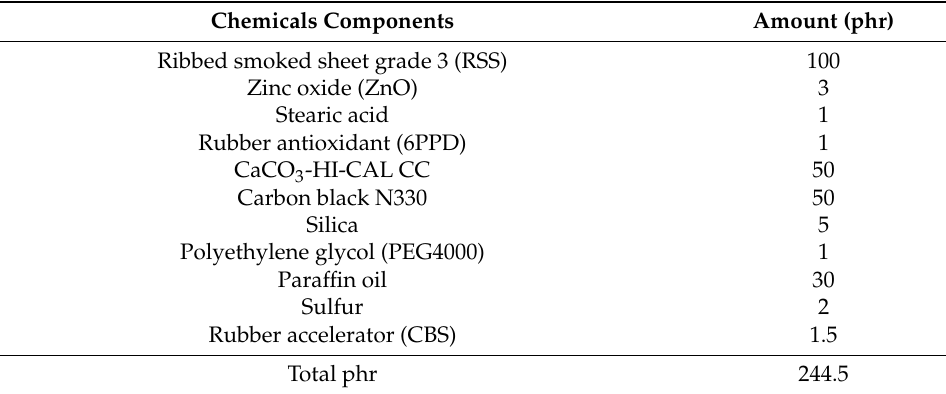
Figure 3b. The average ultimate tensile strength and tensile strength at 2% strain on the MD were approximately 6.614 kN/m and 0.251 kN/m, respectively. While those on the CD were approximately 6.327 kN/m and 0.269 kN/m, respectively. The ultimate tensile strength of the geogrid was typically varying from 0.25 to 14.4 kN/m [24]. Table 1. Composition of rubber compound sheet.